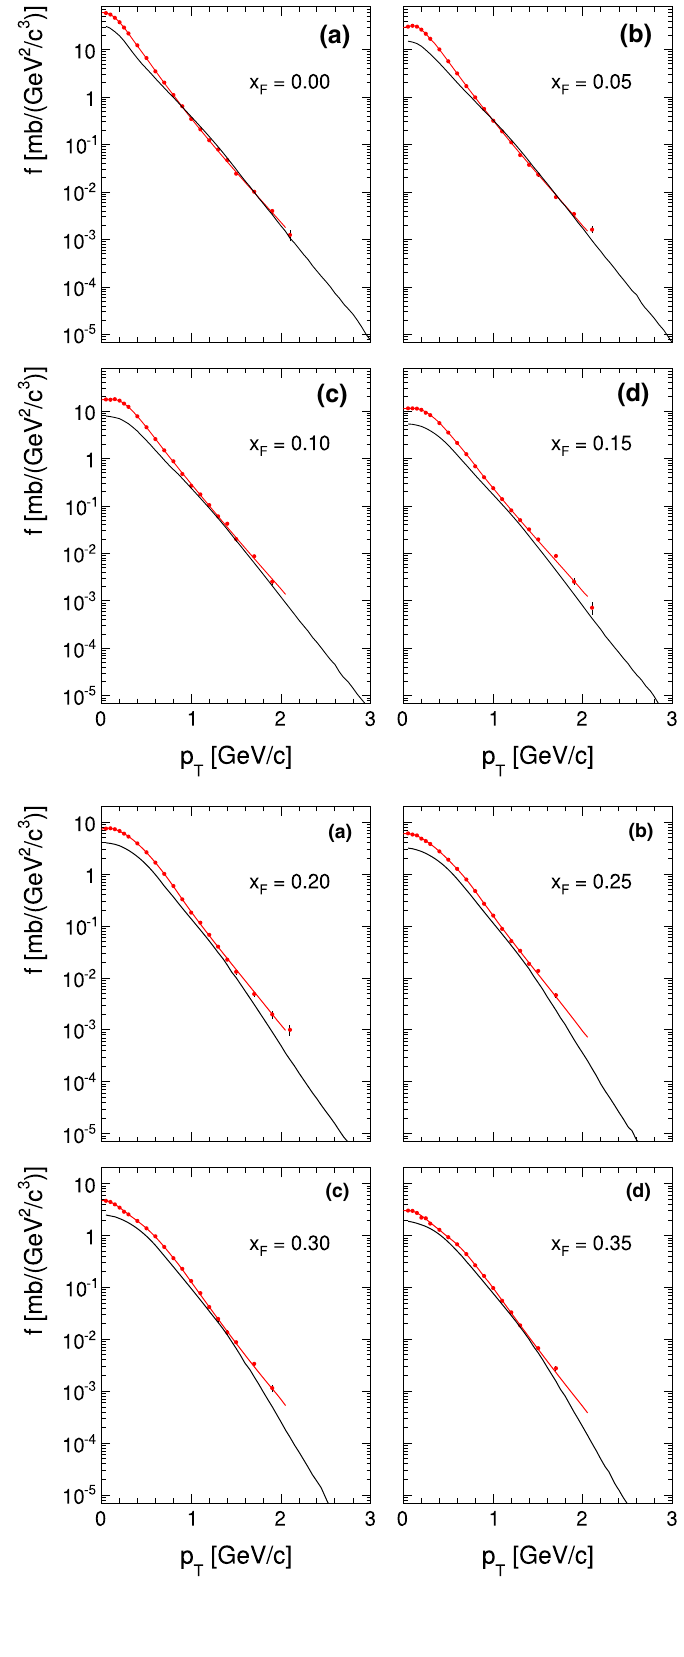
Fig. 184 Predicted invariant π − cross sections from resonance decay as a function of p T for fixed x F = 0.2, 0.25, 0.3 and 0.35. The predictions are given as full lines, the NA49 data as dots and the corresponding interpolations as red